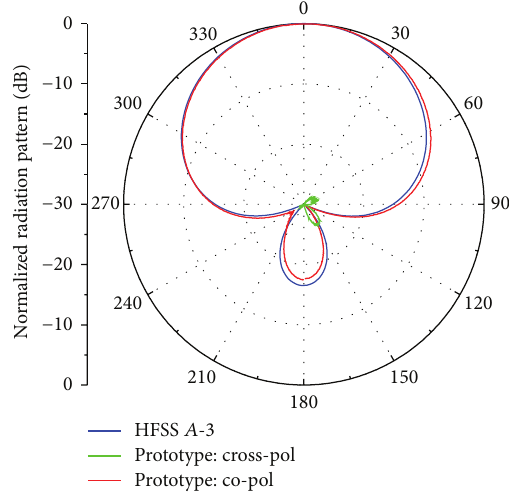
Figure 26: H -plane radiation patterns.